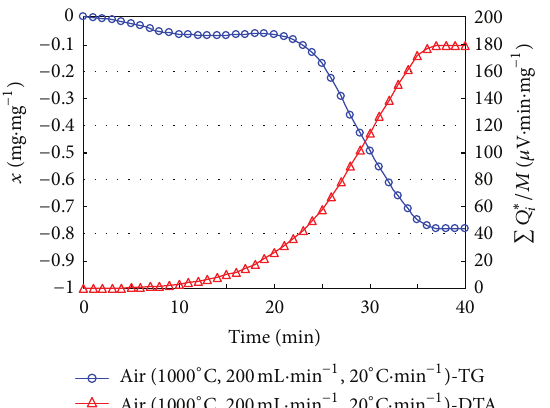
Figure 4: A typical TG-DTA curve of coal combustion in air